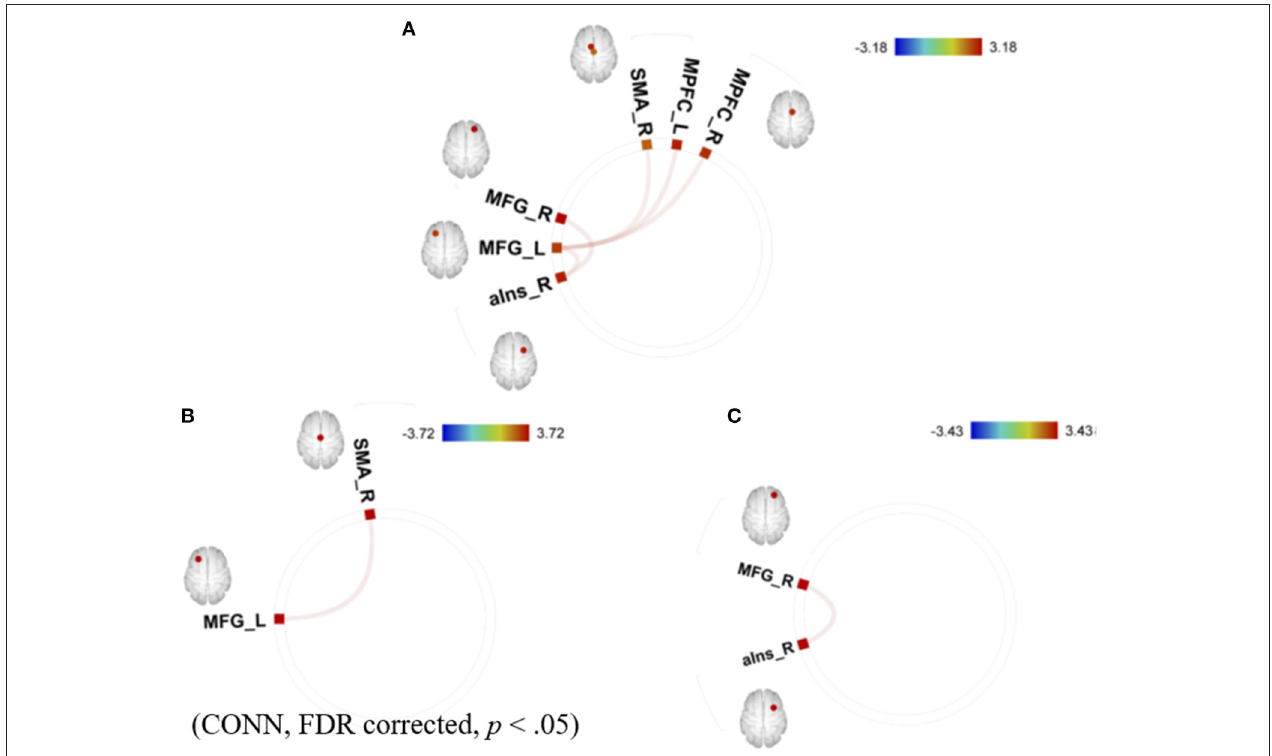
FIGURE 2 | Correlations between (A) total GPIUS2 scores, (B) the scores of mood regulation, and (C) the scores of deficient self-regulation and functional connectivity of the motivation network. MPFC, medial prefrontal cortex; SMA, supplementary motor area; MFG, middle frontal gyrus; aIns, anterior insula; L, left; R, right. The colour bar indicates the positive (red) and negative (blue) T -values for the correlations [Revised from Fujiwara et al.